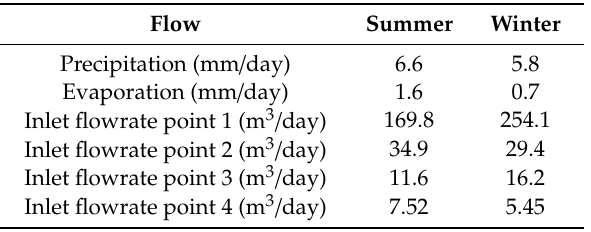
Table 5. Inlet flow rates and average precipitation and evaporation in the Yotsugi mill tailings pond in summer and winter 2016.